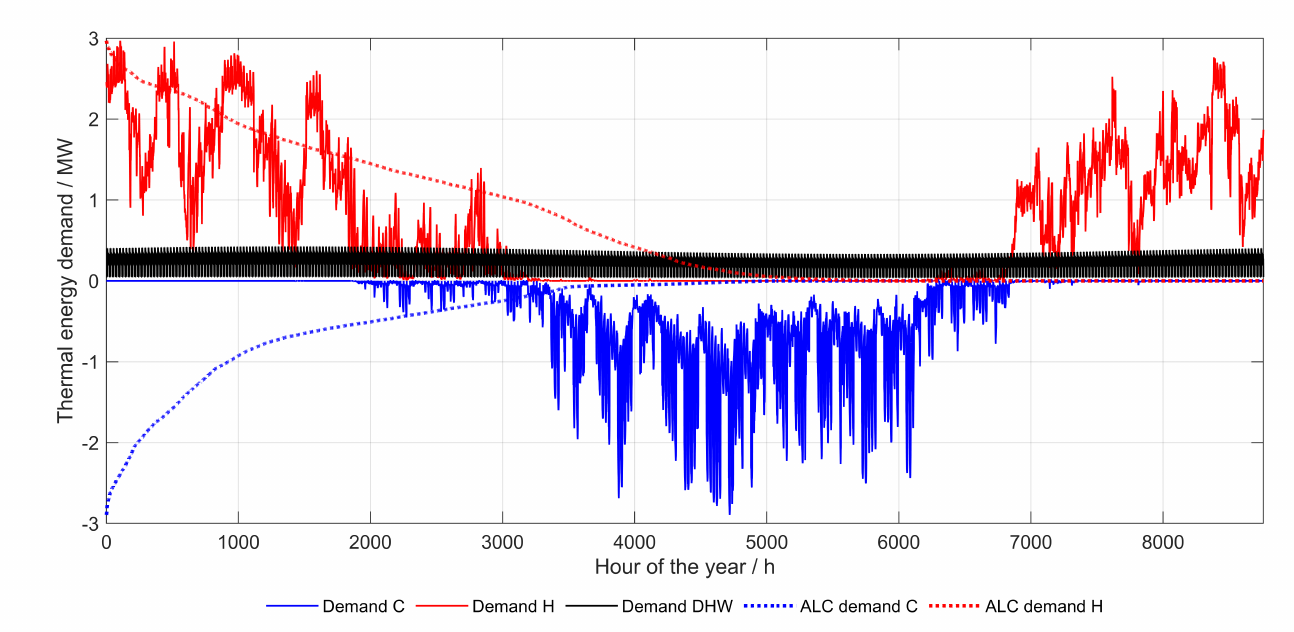
Figure 12. Thermal energy demand for C and H with the corresponding ALC and the DHW demand for szenario